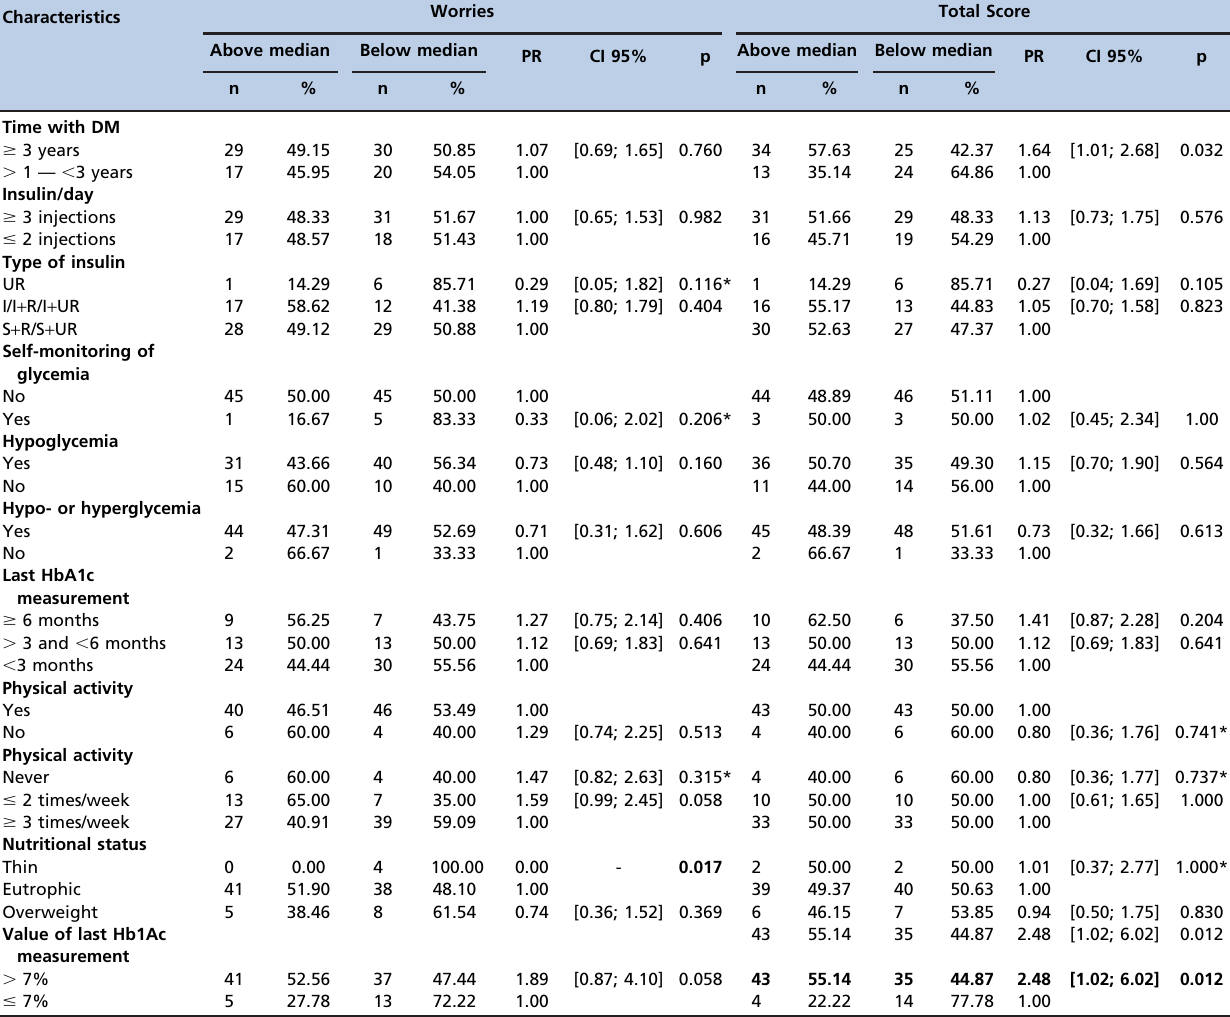
Table 3B - Bivariate analysis of associations between clinical characteristics and the domain ‘‘Worries’’ and the total